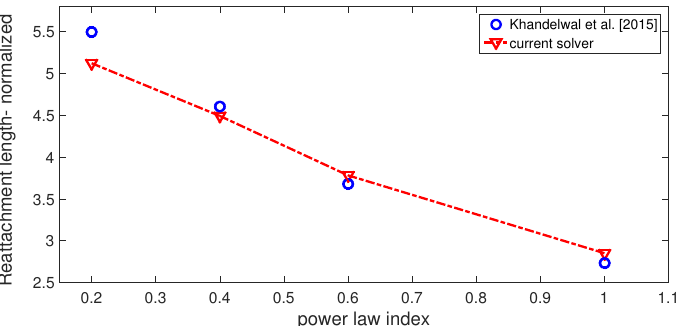
Figure 3. Validation test case 1: Normalized reattachment length versus power law index comparisons between the work of [87] at Re = 100. In the study, the shear thinning fluid flow behavior in a T-channel was analyzed.